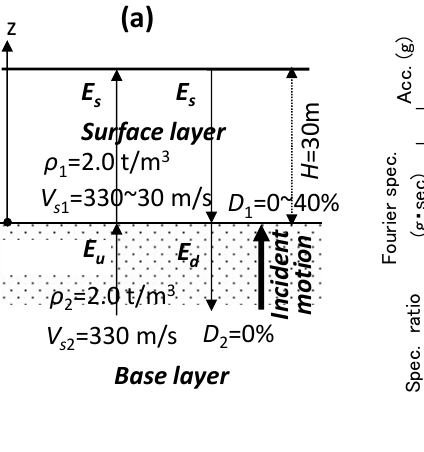
Figure 5. Energy flow in two-layer system by harmonic motion with D 1 = 5% and D 2 = 0%. Surface energy ratio E s / E u ( a ) and dissipated energy ratio E w / E u ( b ) versus impedance ratio  .